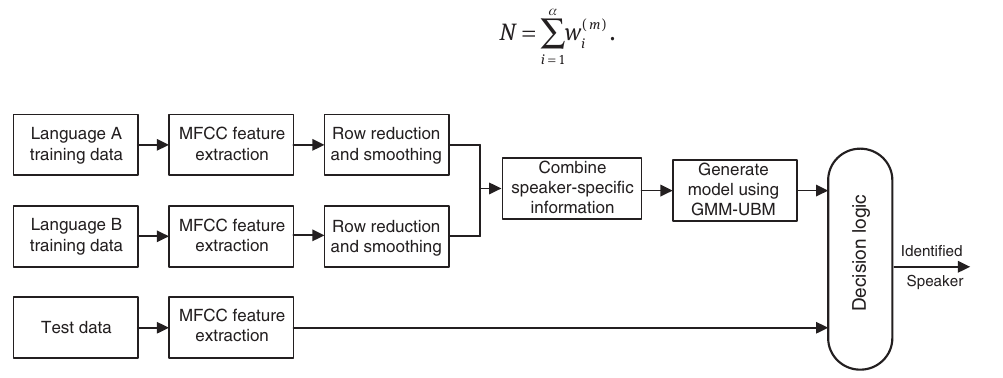
Figure 2: Block Diagram of the Combination of Speaker-Specific Information from Different Languages for Crosslingual Speaker